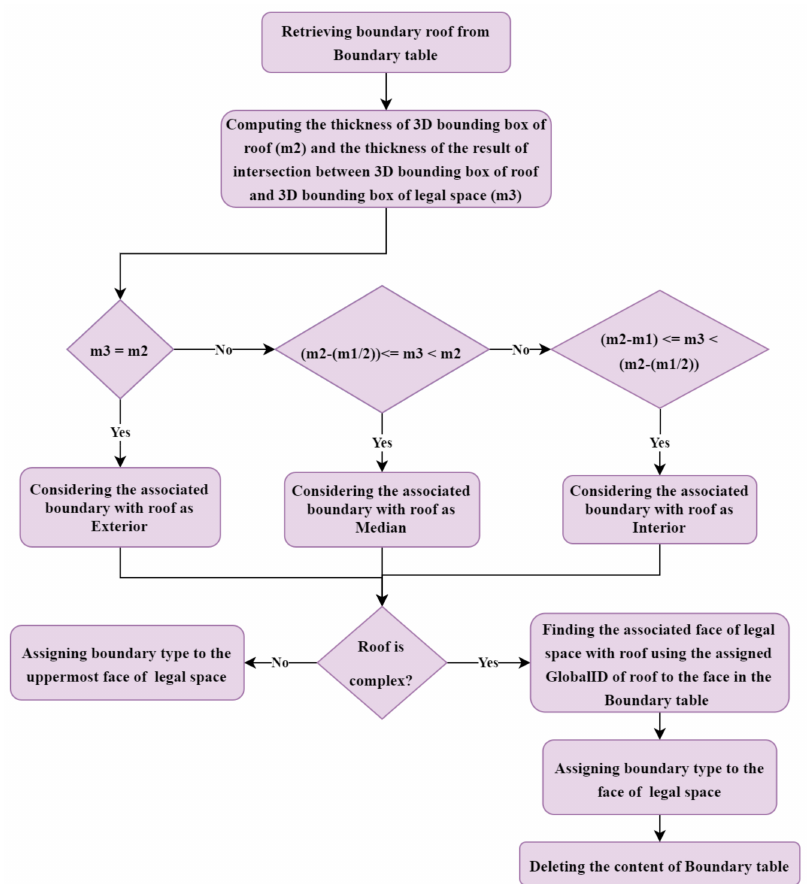
Figure 9. A methodology for detecting different types of property boundaries associated with